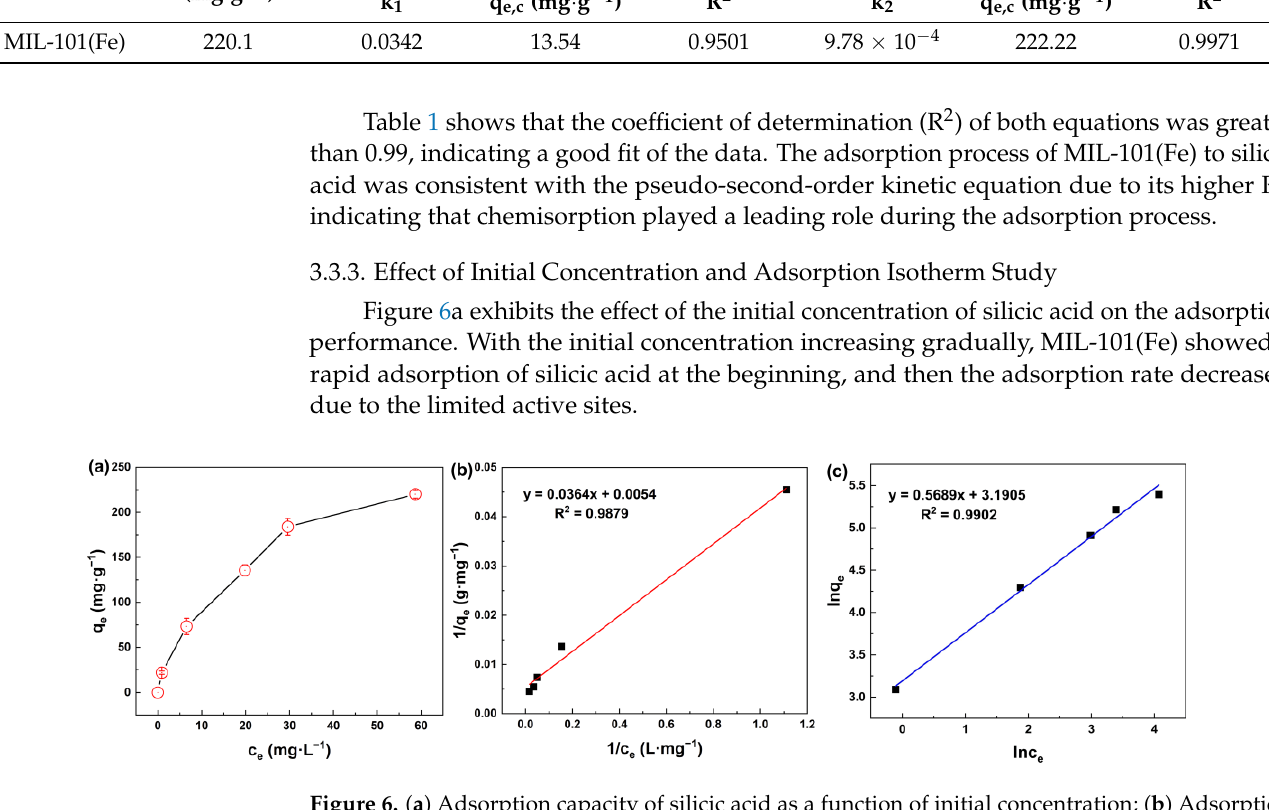
Figure 6. ( a ) Adsorption capacity of silicic acid as a function of initial concentration; ( b ) Adsorption isotherms of the silicic acid adsorption process with the Langmuir isotherm model; ( c ) Adsorption isotherms of the silicic acid adsorption process with the Freundlich isotherm model. Langmuir and Freundlich isotherm models [56] are normally expressed as Equations (5) and